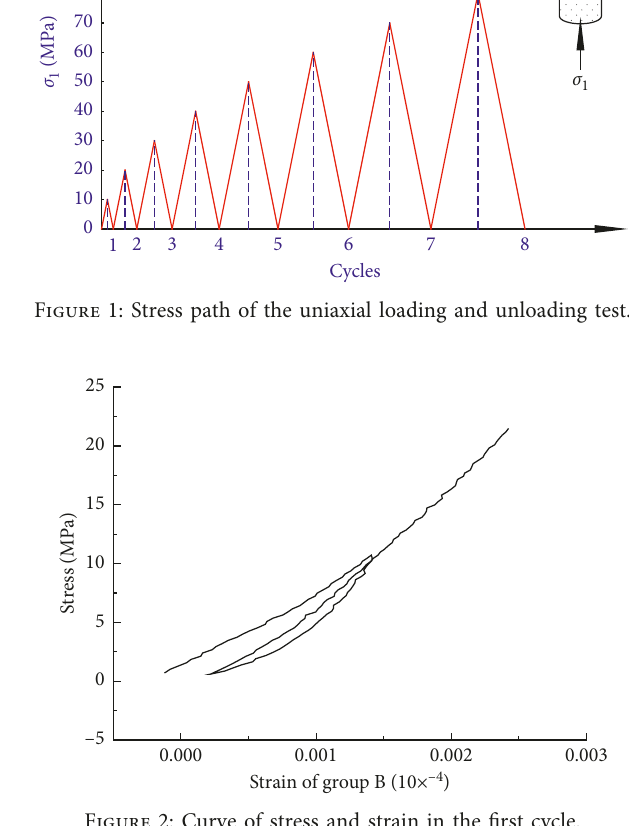
Figure 2: Curve of stress and strain in the first cycle.